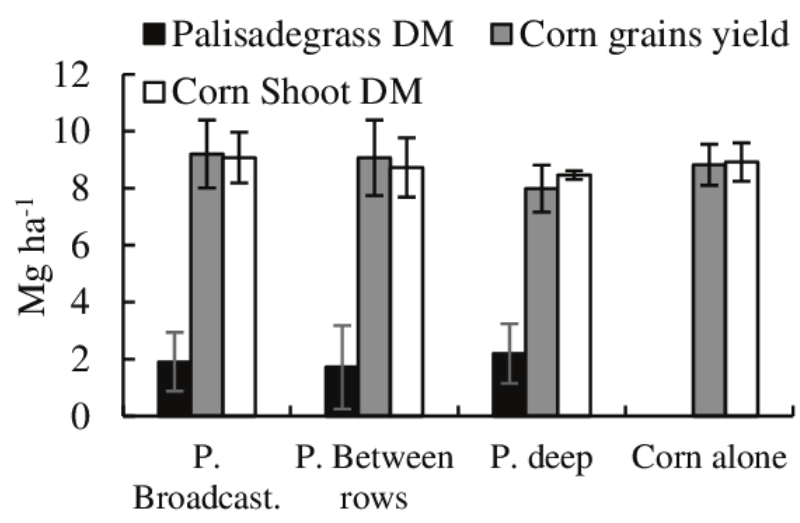
Figure 2 - Dry mass (DM) and grains yield of corn and palisadegrass. The bars represented the standard error of the